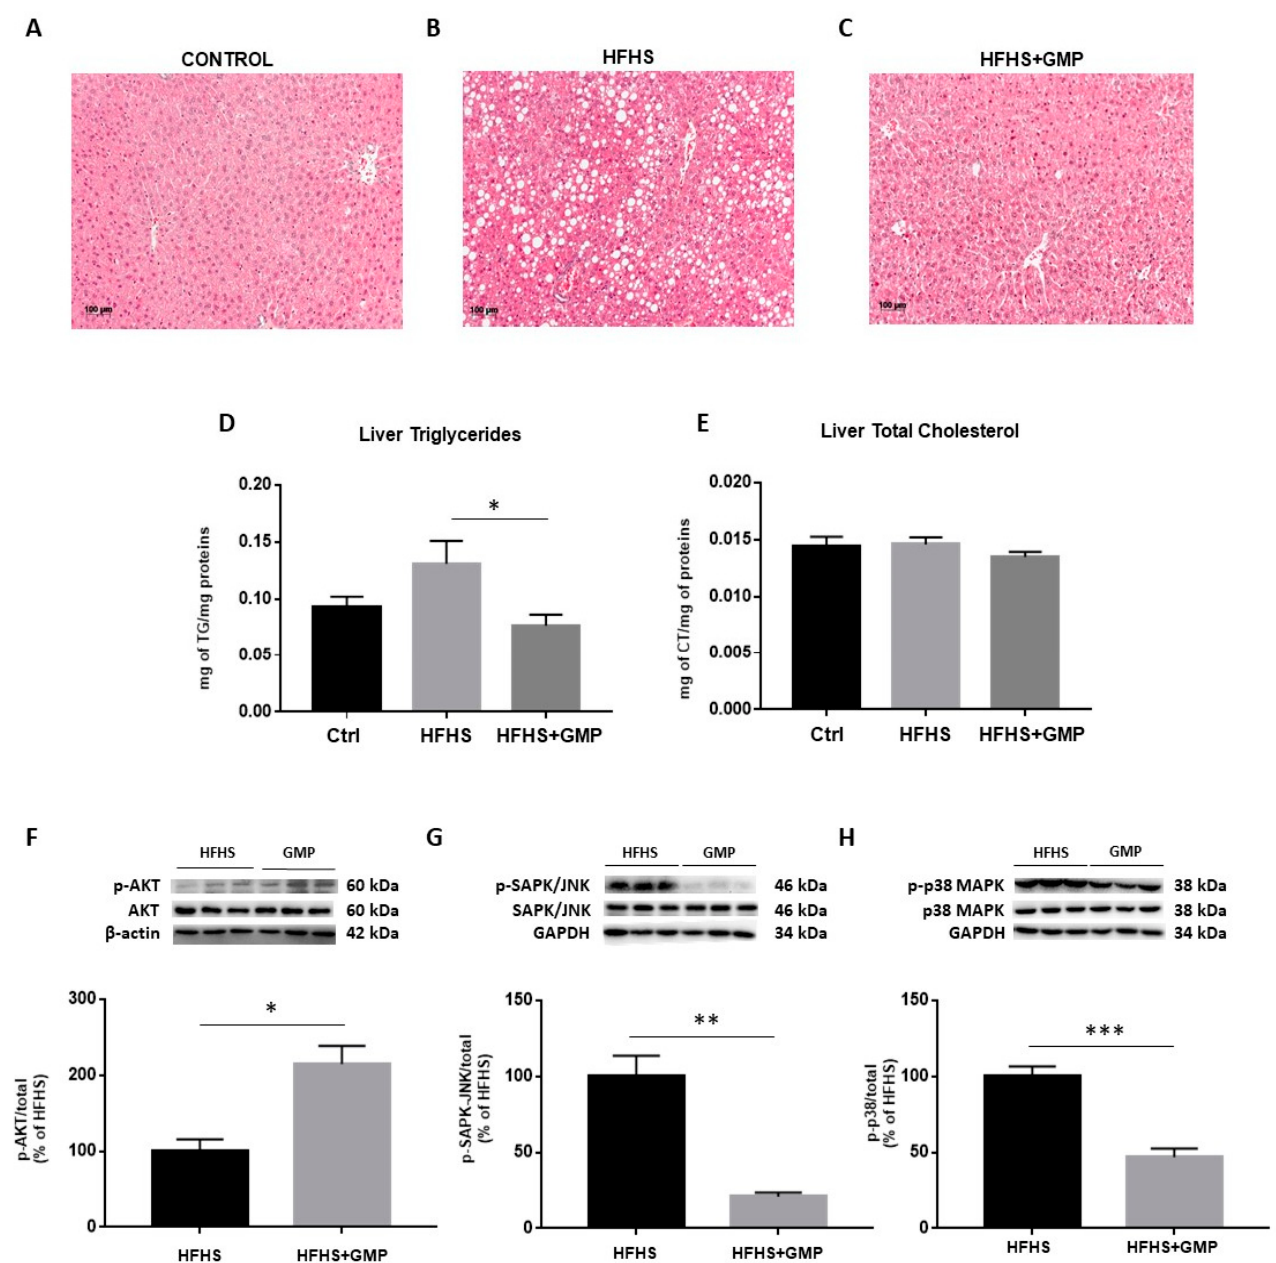
Figure 4. GMP reduces hepatic lipid accumulation and modulates insulin signaling pathway in HFHS-fed mice. Rep- resentative images of hematoxylin phloxine saffron stained liver sections of ( A ) chow- (Ctrl), ( B ) high-fat, high-sucrose (HFHS)- and ( C ) HFHS+GMP-fed mice; ( D ) Triglycerides and ( E ) total cholesterol content was quantified in liver of n = 10 mice/group; Protein expression of pivotal biomarkers influencing insulin sensitivity was determined in liver by Western blot as described in Material & Methods. ( F ) p-AKT/AKT, ( G ) p-SAPK/JNK/SAPK-JNK and ( H ) p-p38 MAPK/p38 MAPK ratios were calculated. Results represent the mean ± SEM for n = 3–6 mice/group. * p < 0.05, ** p < 0.01, *** p < 0.001 vs. HFHS-fed mice.